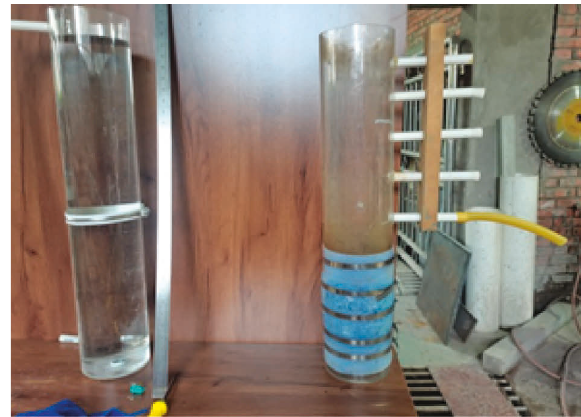
Figure 6: Non-Darcy flow permeability coefficient tester for compacted PFC-13 specimen.